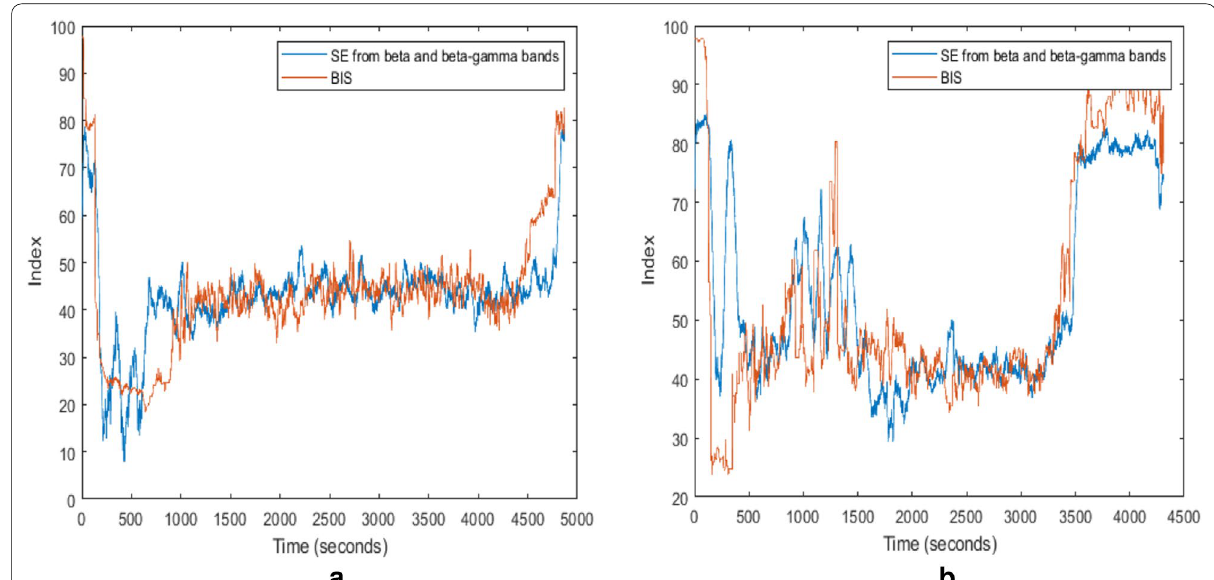
Fig. 6 The index from the linear regression equation of the SE calculated from β and βγ frequency bands vs. the BIS Index. a Patient ID 9; b Patient ID